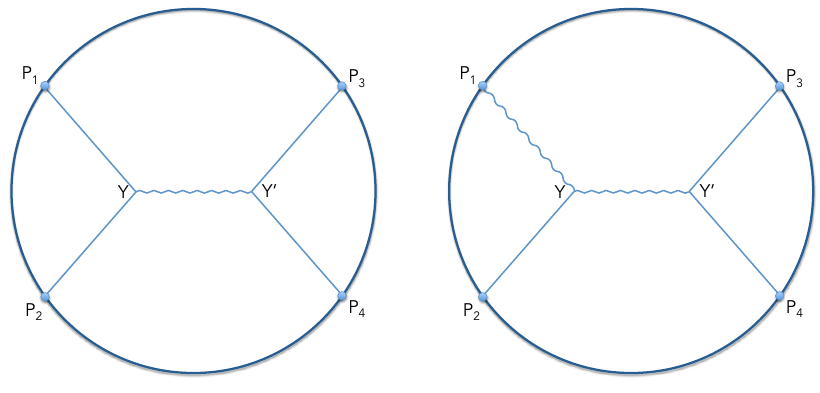
Figure 6 . Four-point exchange Witten diagrams in AdS d +1 , where the exchanged (cid:12)eld is a sym- metric tensor (cid:12)eld of dimension (cid:1) and spin J . In (5.23) and (5.24) we consider explicit examples where J = 1 for the external and exchanged